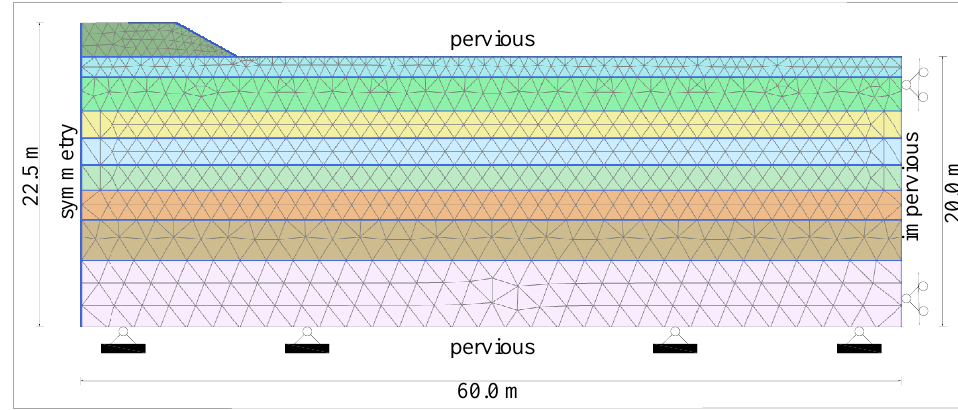
Figure 5. Mesh and boundary conditions — Embankment A.